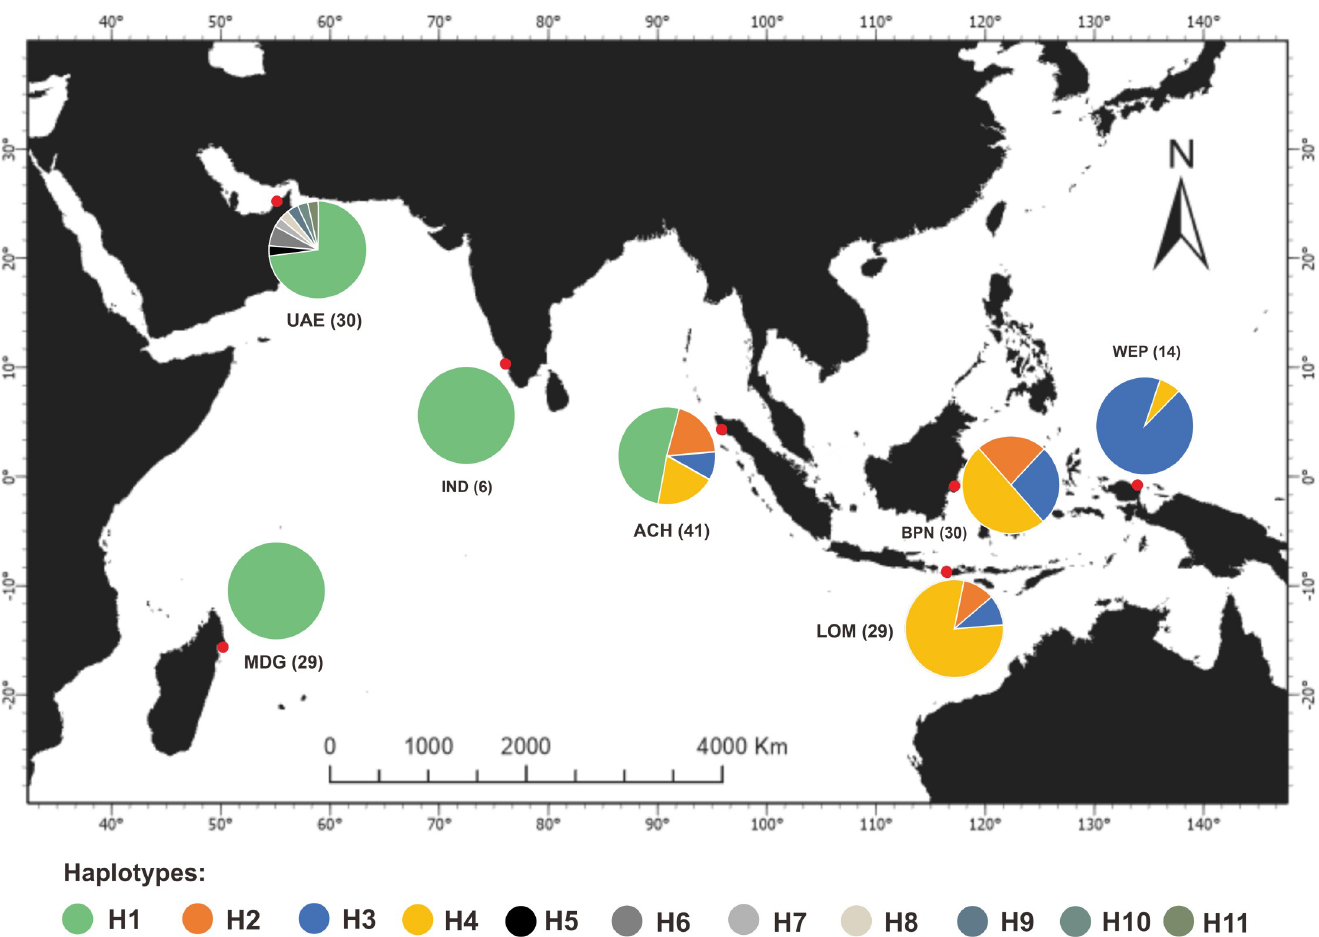
Fig 2. Distribution of the 11 haplotypes of the S . lewini population from Indonesia and Western Indian Ocean at the regional scale.